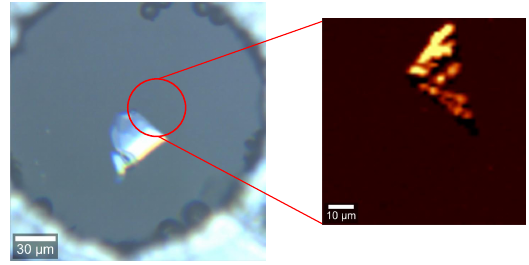
Figure 1: (Left panel) Optical image of the DAC loaded with a single-layer of WSe 2 (plus some bulk and few lay- ers) at a pressure of ca. 5.4 GPa. The monolayer is only apparent in the PL map (right panel), corresponding to a scan of the A-exciton peak intensity of the WSe 2 ML across the